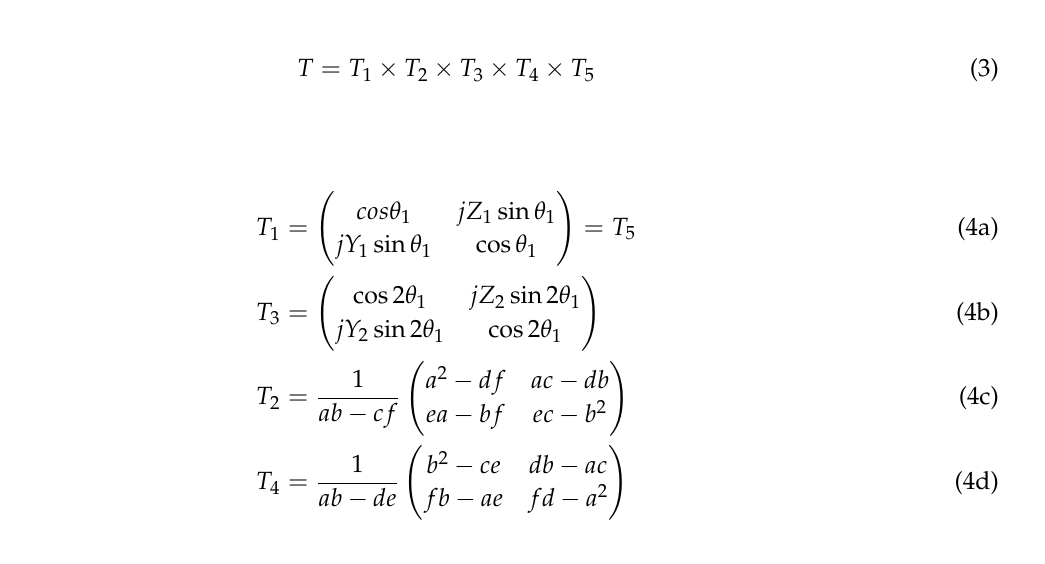
Figure 2. Equivalent circuit and MATLAB simulated results of resonators in upper path I. ( a ) Equivalent circuit of different sections in upper path I. ( b ) MATLAB simulated results of different sections in upper path